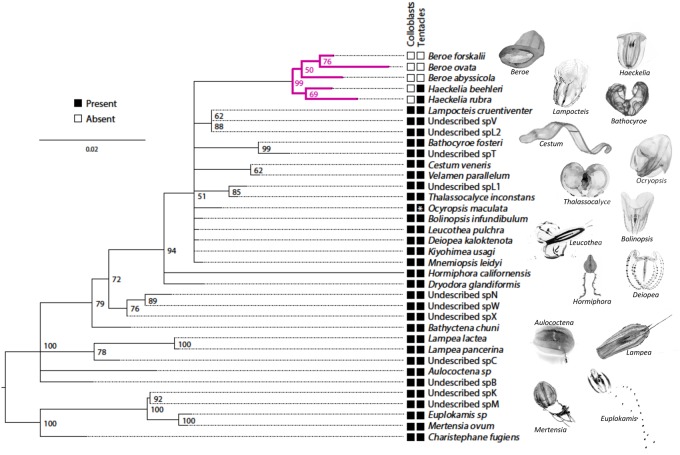
Beroe and Haeckelia are nested within Ctenophora. An 18S phylogeny of 36 species of ctenophore. Bootstrap support values are indicated at the nodes and branch length indicates rate of substitution. Clades with <50% bootstrap support have been collapsed. Shaded boxes indicate the presence of the indicated trait. *Indicates the presence of tentacles only in the larval stage.